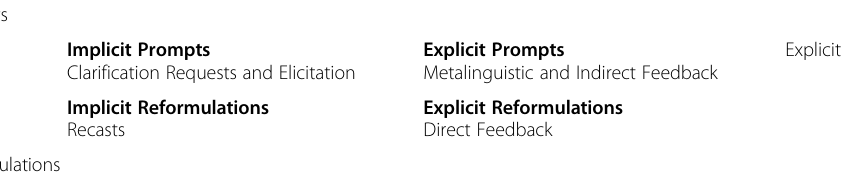
Explicit Prompts Metalinguistic and Indirect Feedback Explicit Reformulations Direct